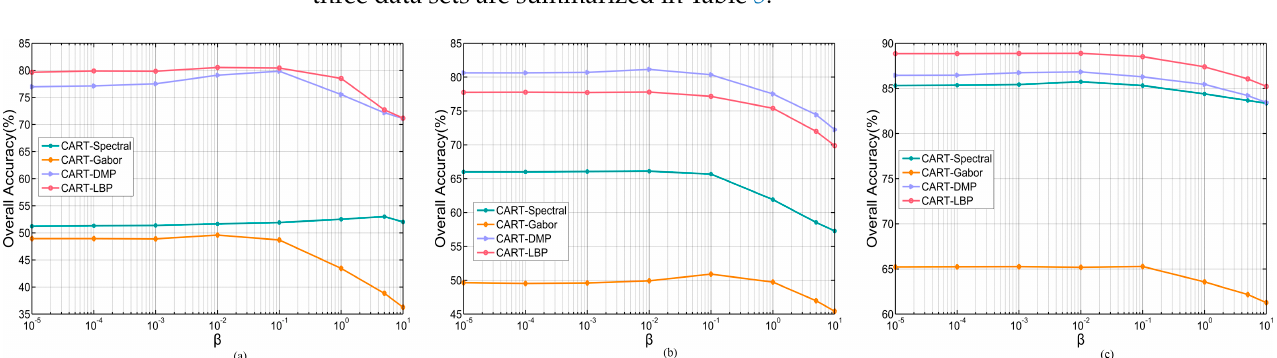
Figure 5. Classification accuracy versus varying λ for the proposed MFCARC and MFCART methods. ( a ) Indian Pines.